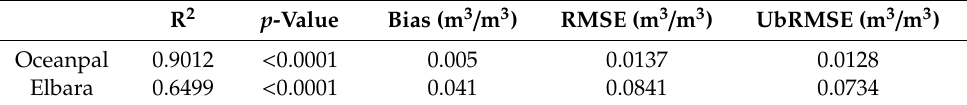
Table 3. Statistic errors between the retrieved soil moisture and in situ measurements.